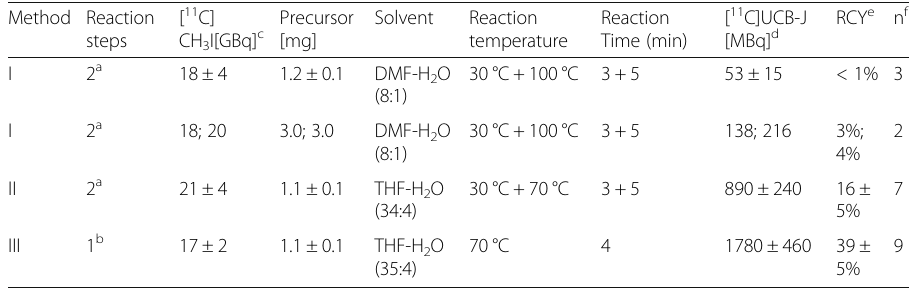
Table 1 Optimization of the [ 11 C]UCB-J synthesis Method Reaction